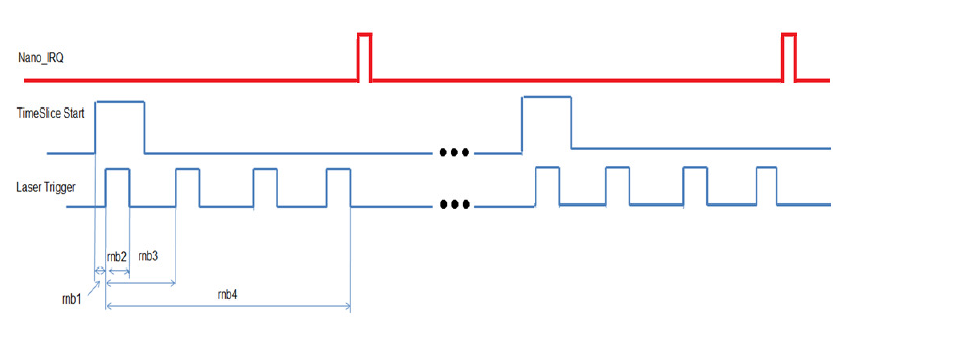
Figure 2 . Example of the behaviour of the Nanobeacon firmware with respect to the time